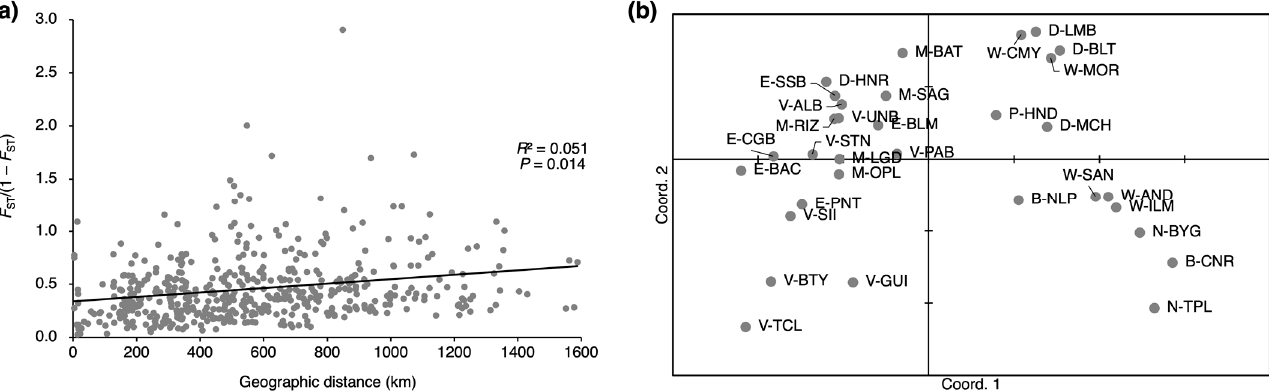
Figure 2. ( a ) Isolation-by-distance for all sites except for P-PPB based on pairwise F ST /(1 − F ST ) values plotted against geographic distance (km) using the Mantel test. ( b ) Principal coordinates analysis (PCoA) from the covariance matrix based on pairwise F ST values except for P-PPB. The first two axes explained 35.97% of the variation (the first axis explained 24.14%, the second axis, 11.83%). The values of pairwise F ST are shown in Table S3.